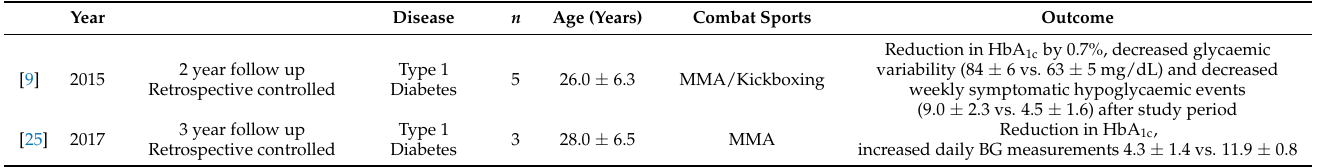
Table 1. Study characteristics, clinically diagnosed individuals with type 1 diabetes and combat